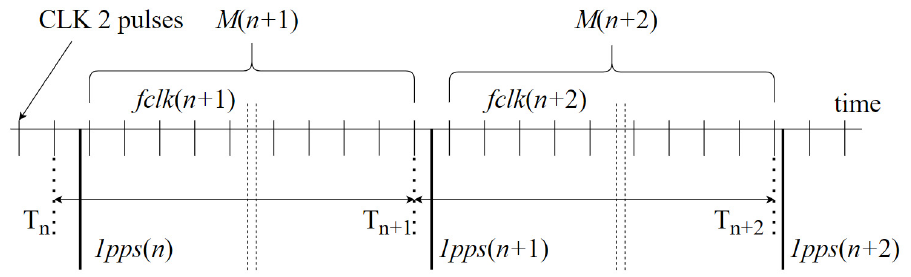
Figure 6. Time diagram of the counting process.